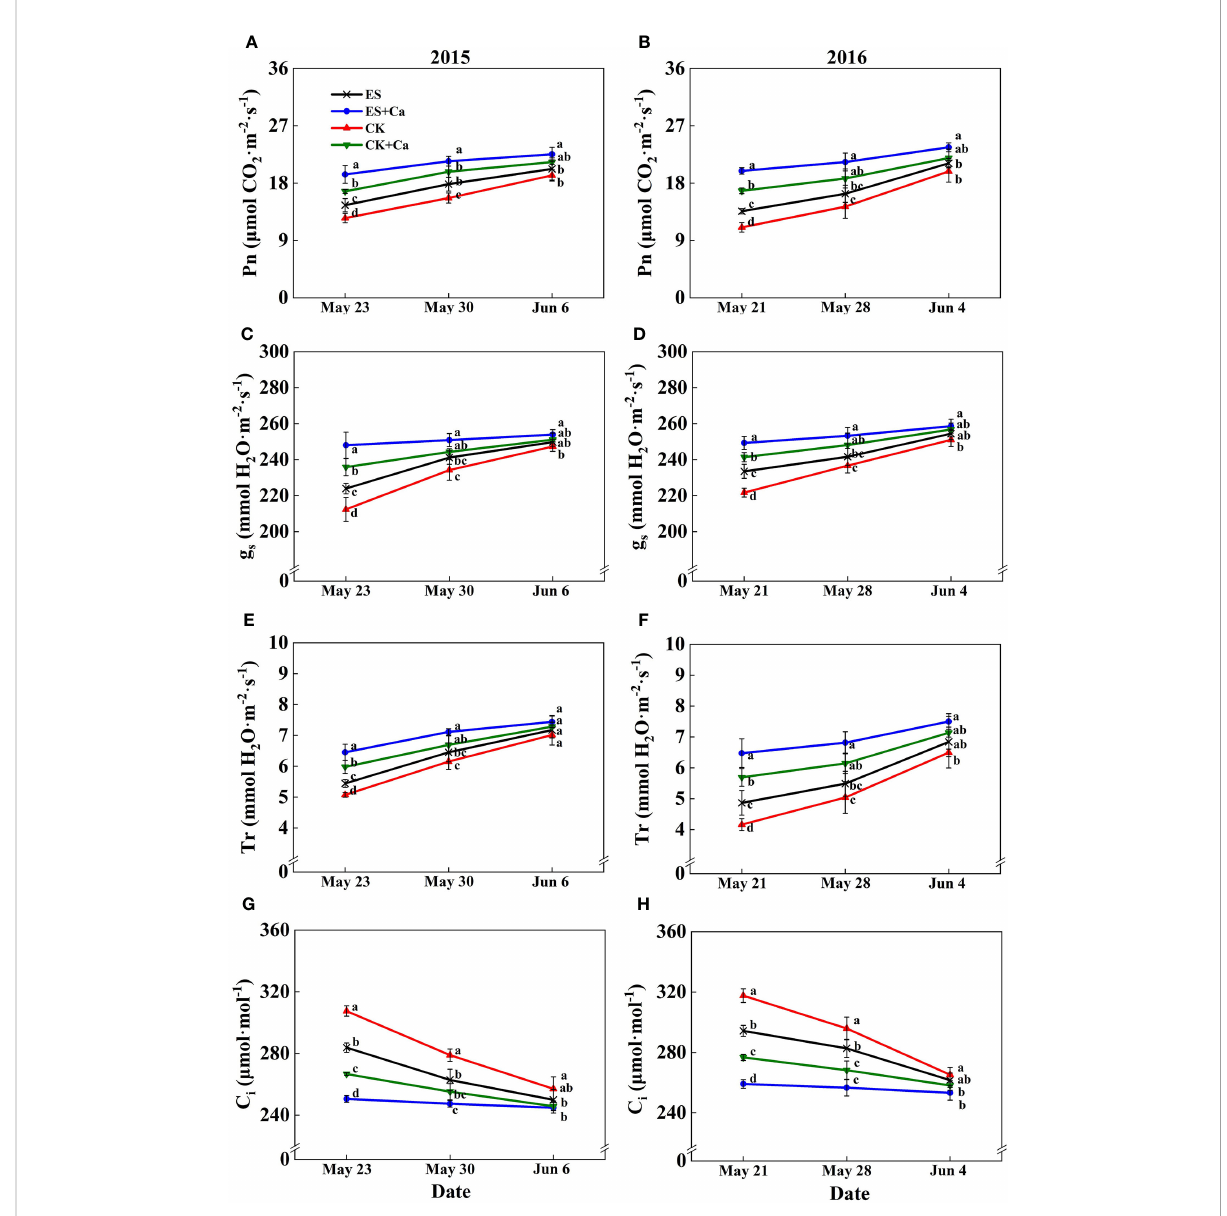
FIGURE 5 Effects of exogenous foliar calcium (Ca 2+ ) application on peanut net photosynthetic rate (Pn, A , B ), stomatal conductance (g s , C , D ), transpiration rate (Tr, E , F ), intercellular CO 2 concentration (Ci, G , H ) under early and normal sowing scenarios. Values are means ± SD (n = 3). Different letters indicate signi fi cant differences according to Duncan ’ s multiple range tests ( p <